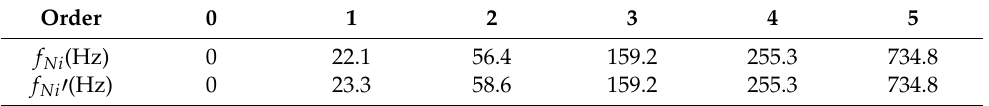
Table 4. Natural frequencies of the driveline under different drive modes.